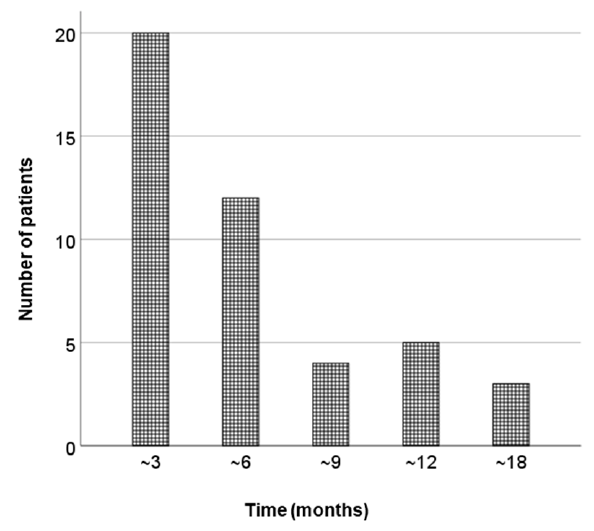
Figure 4. Time to recover from PSA bounce. PSA, prostate-specific antigen.